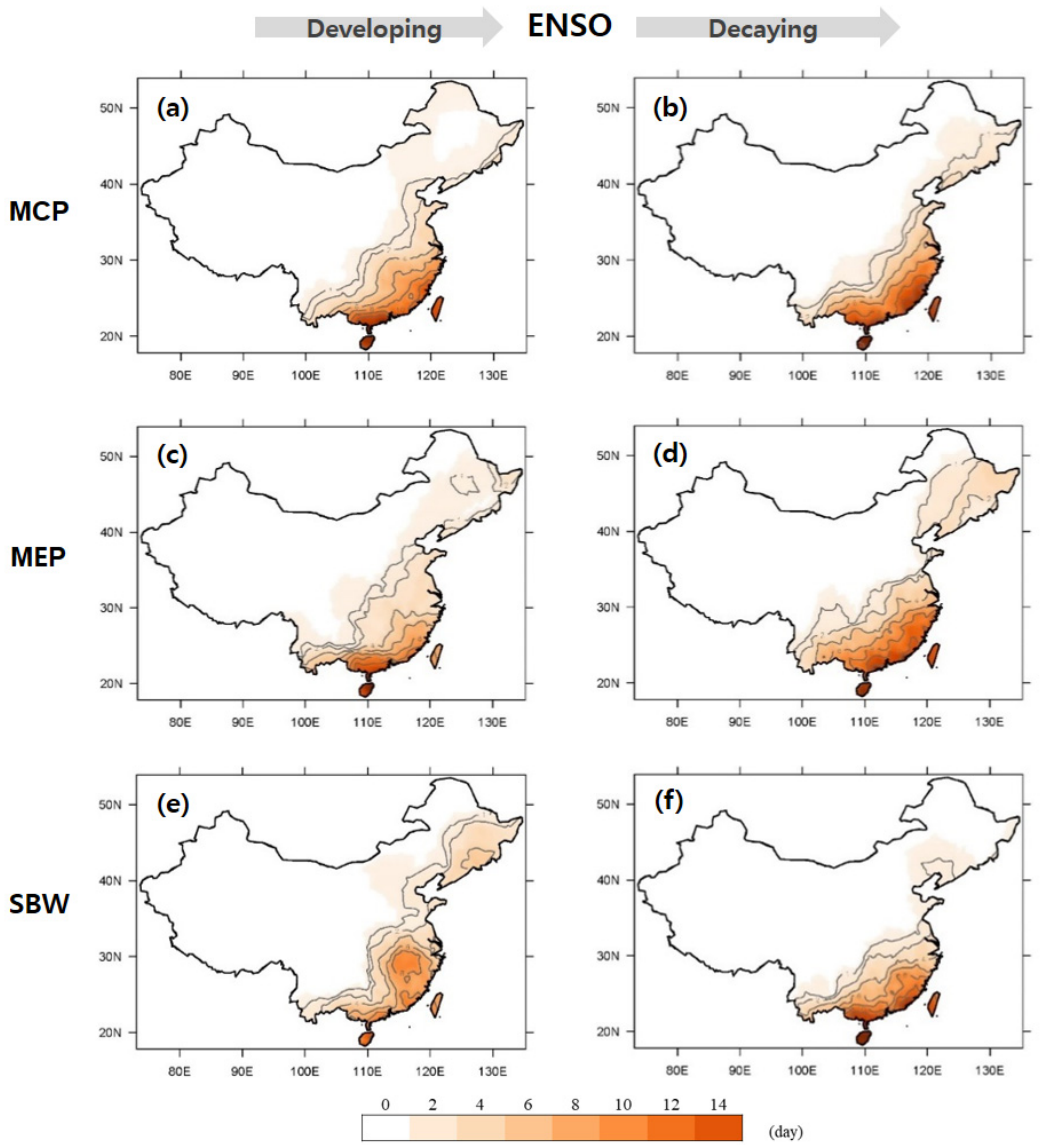
Figure 9. Composite anomaly map showing the average number of days per year affected by tropical cyclones. The contour lines, as they extend from west to east, indicate areas affected on 1, 2, 4, 6, 8, 10, and 12 days per year. Dark orange areas denote areas that were affected by anomalies in all years, which mainly include the Pearl and Southeastern river basins and offshore islands. MCP: moderate central Pacific, MEP: moderate eastern Pacific, SBW: strong basin-wide. ( a , b ) moderate central Pacific (MCP); ( c , d ) moderate eastern Pacific (MEP); ( e , f ) strong basin-wide (SBW).